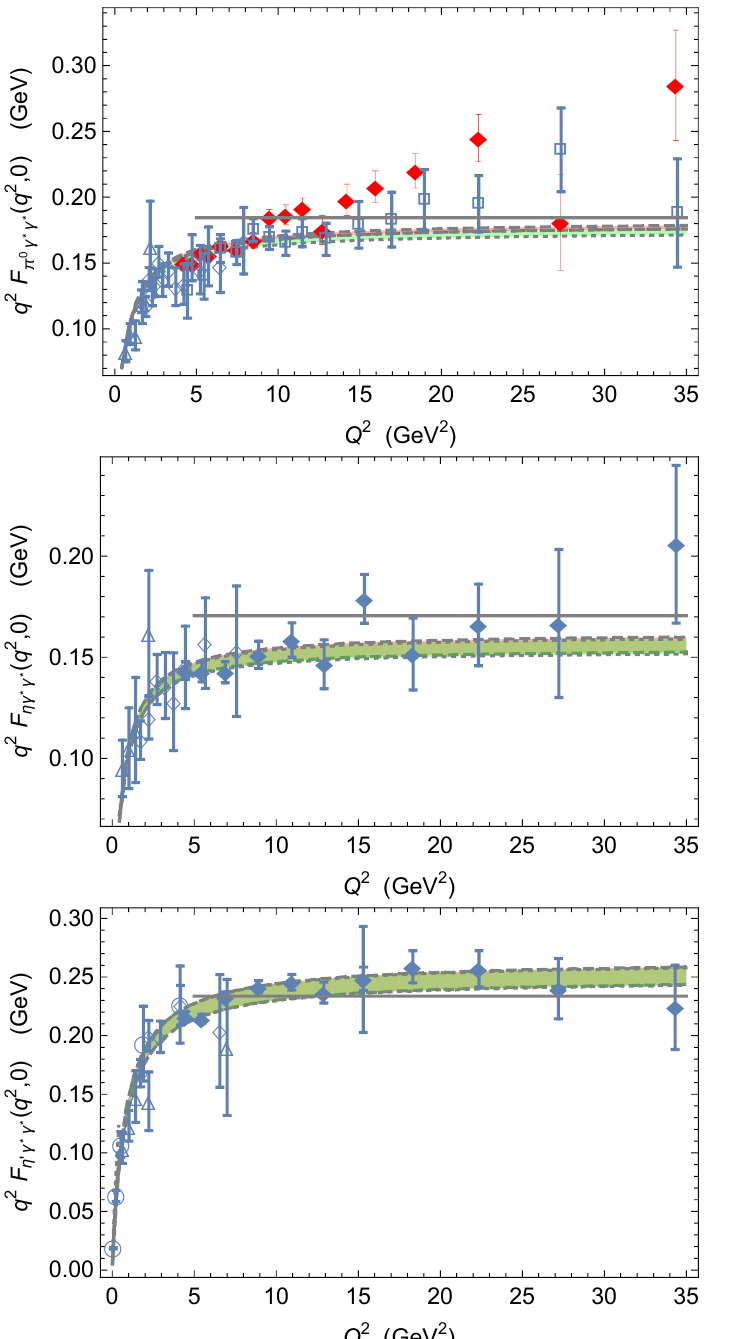
Figure 4 . Comparison between the (cid:25) 0 (top), (cid:17) (middle) and (cid:17) 0 (bottom) TFFs from the (cid:12)t to all data (darker red band with dashed borders) and the (cid:12)t after removing BaBar (cid:25) 0 data (clearer green band with dotted borders). See the text for details.